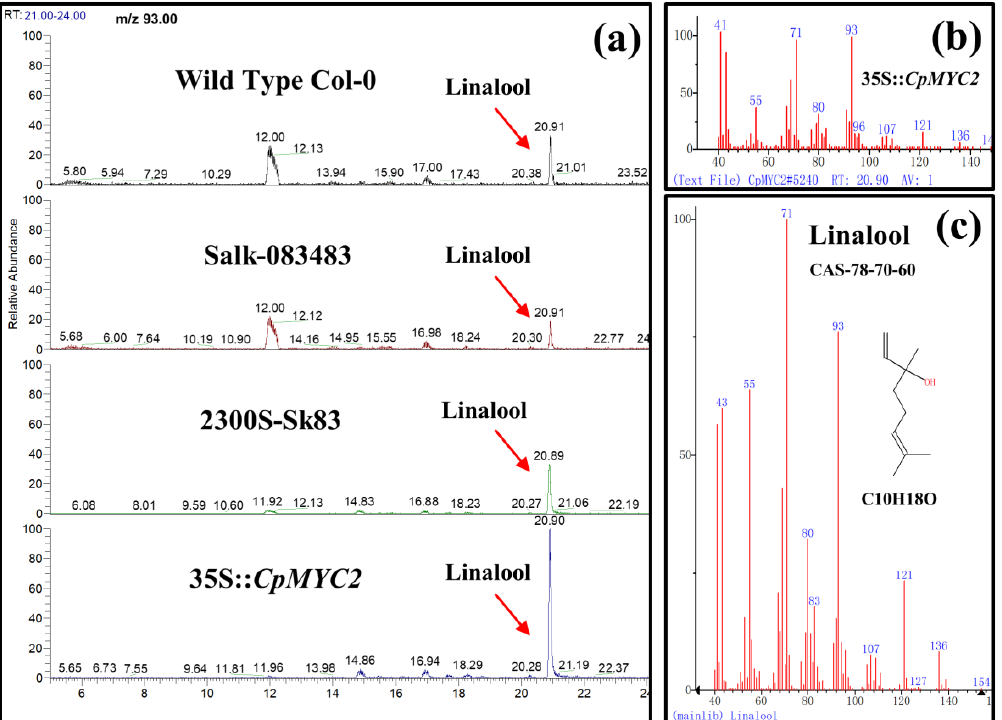
Figure 9. The concentration of emitted linalool (ng g-1 FW h-1) after the application of methyl jasmonic acid (MeJA) and gibberellic acid (GA3) from arabidopsis wild type (WT-Col-0), mutant (Salk_083483), mutant Salk_083483 transformed by the empty vector pCAMBIA2300S (2300S-Sk83), and CpMYC2 gene (35S:: CpMYC2 ) plants. The different letters on the bars show significance between the treatments by using least significant difference (LSD) at p < 0.05.